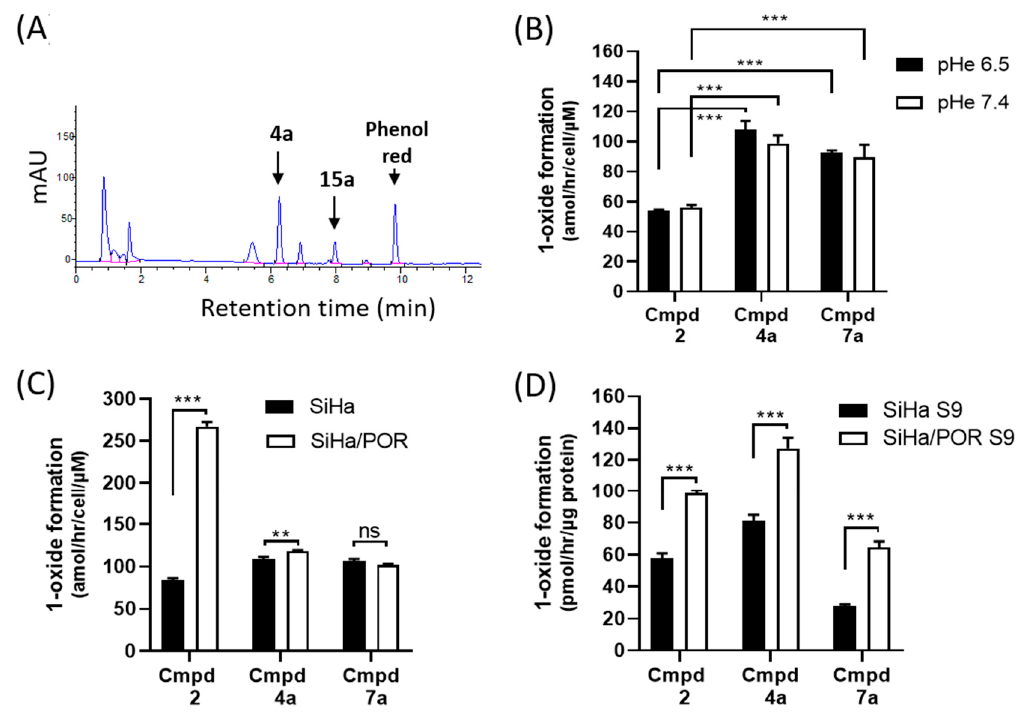
Figure 5. Reductive metabolism of BTO acids and SN30000 to the corresponding N- 1-oxides by anoxic cultures in 96-well plates. ( A ) Absorbance chromatogram demonstrating the formation of N- 1-oxide 15a from 4a (initially 50 µ M) by SiHa cells (2 × 10 6 cells / mL) after 2 h. All unlabeled peaks were also observed in drug-free controls. ( B ) Rate of formation of N -1-oxide metabolites in the extracellular medium, as in (A), at two di ff erent extracellular pH values. ( C ) Formation of extracellular N -1-oxides in SiHa and SiHa / POR cultures (2 × 10 6 and 5 × 10 5 cells / mL, respectively) at pHe 7.4. ( D ) Formation of N -1-oxides by post-mitochondrial supernatants from SiHa and SiHa / POR cells under anoxia. Values in (B), (C), and (D) are means and SEM for triplicate cultures. Statistical significance of di ff erences (ns, p > 0.05; **, p < 0.01; ***, p < 0.001) was tested by one-way ANOVA.